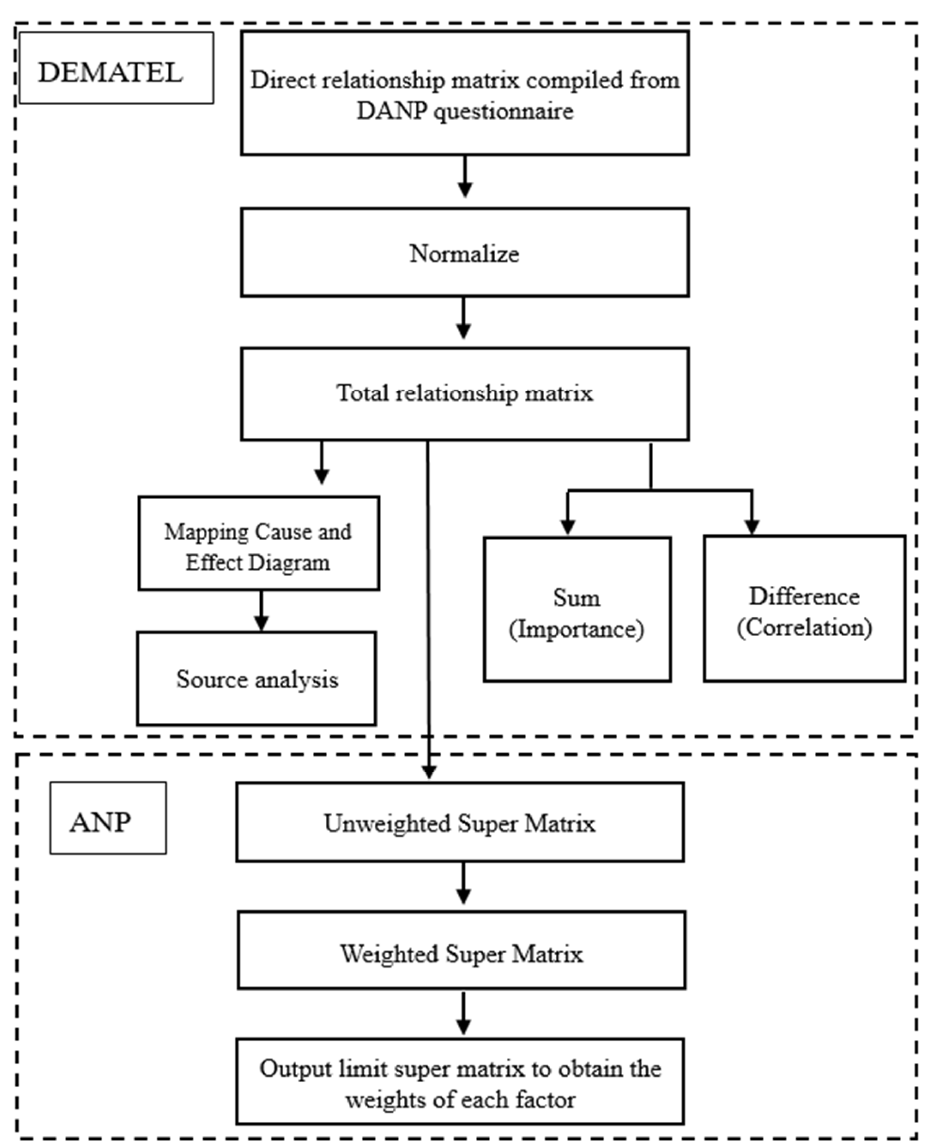
Figure 1. DANP operational steps.